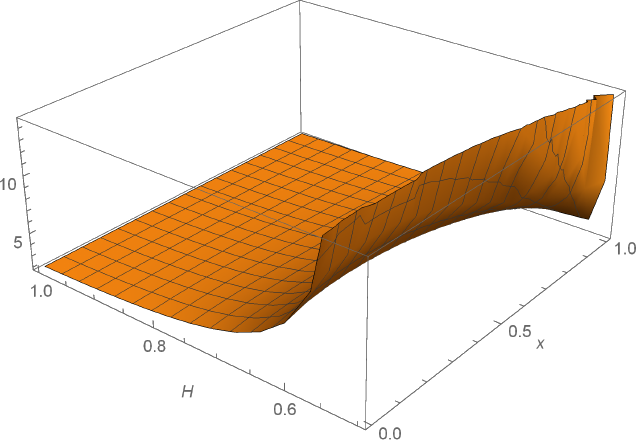
Figure 4. The function ψ ( H , x ) as a surface.